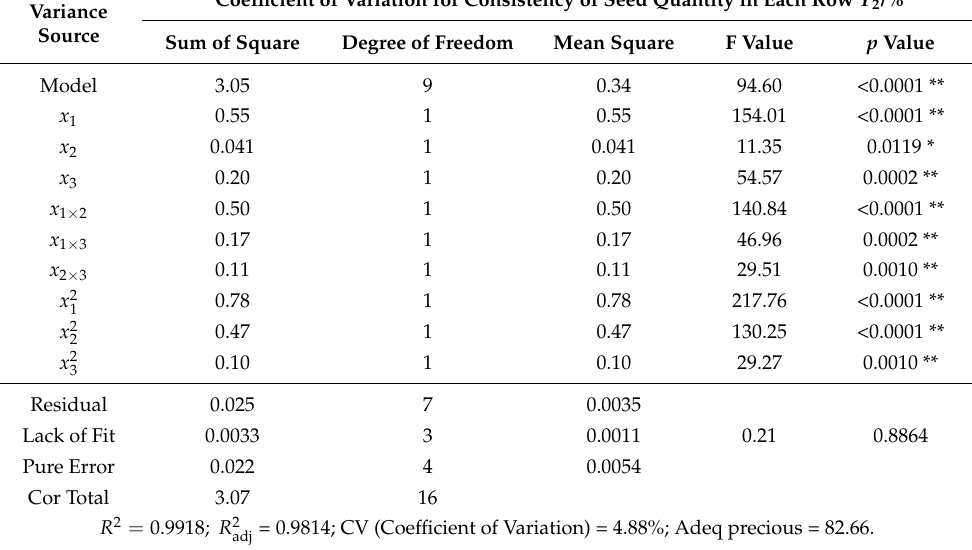
R 2 = 0.9918; R 2 = 0.9814; CV (Coefficient of Variation) = 4.88%; Adeq precious = 82.66. adj Note: ** and * indicated significance at 0.01 and 0.05 levels.